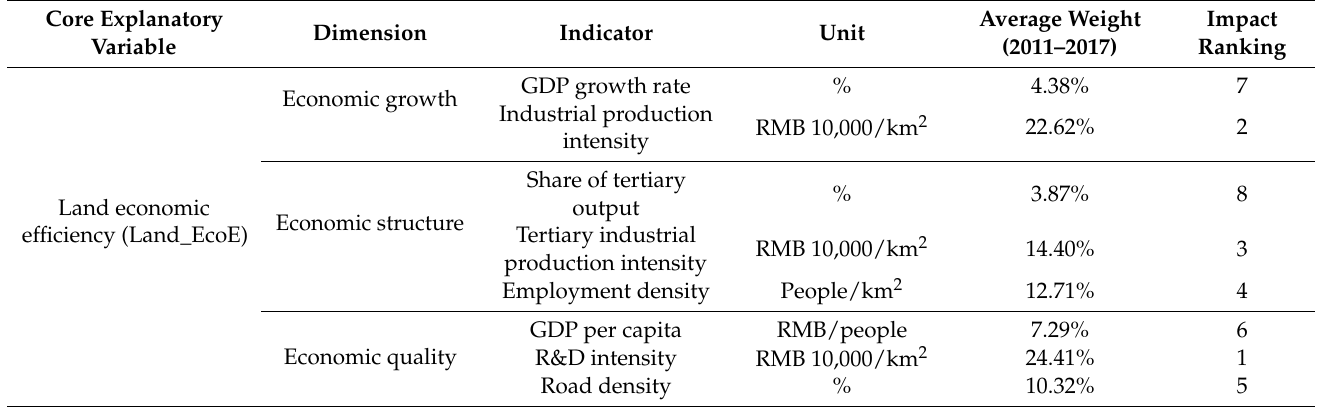
Table 1. Indicator evaluation system of land economic